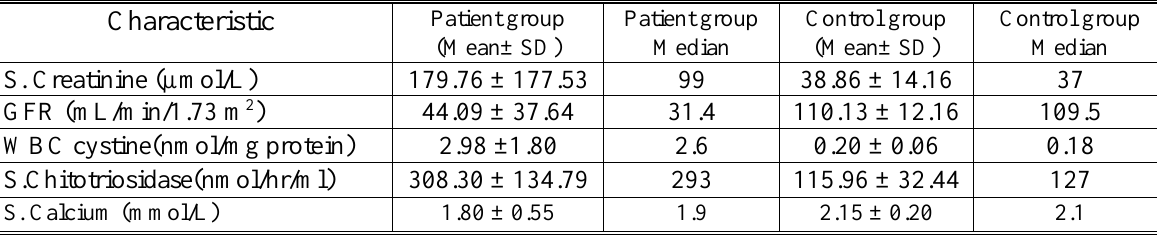
GFR=Glomerular Filtration Rate, Normal S.Cr range is 26 to 62 μmoles/liter, , Normal cystine level (Mixed leukocytes test) is less than 0.2 nm/mg protein, Normal Chitotriosidase level is < 78.5 nmol/hr/ml, Normal S.Calcium range is 2.2-2.6 mmol/L.